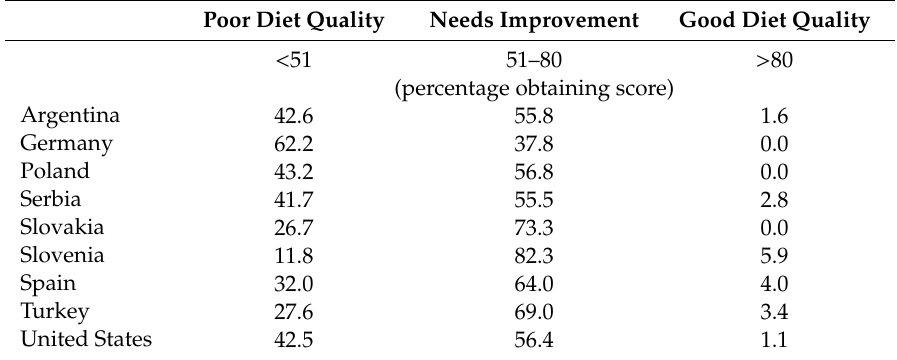
Table 5. Proportion of Subjects in Each Country with Poor Diet Quality Based on Healthy Eating Index-2015 (HEI-2015) Total Diet Quality